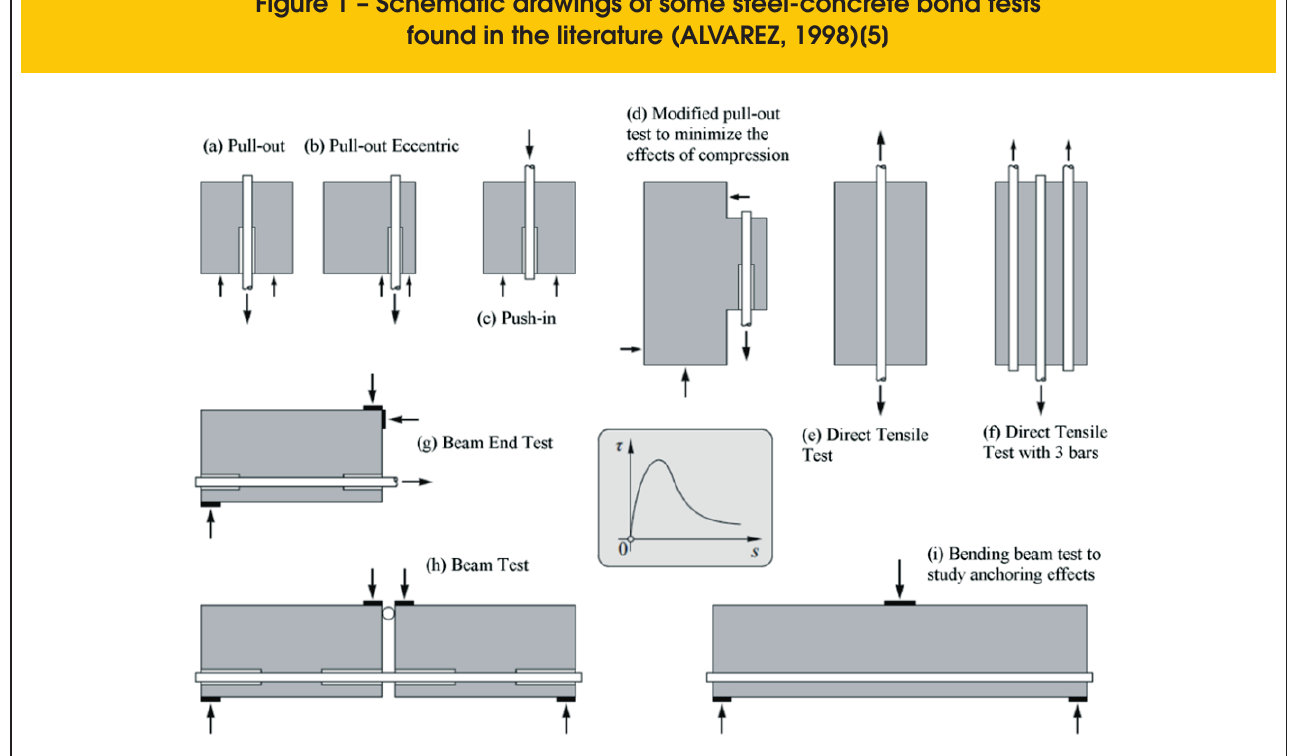
Figure 1 – Schematic drawings of some steel-concrete bond